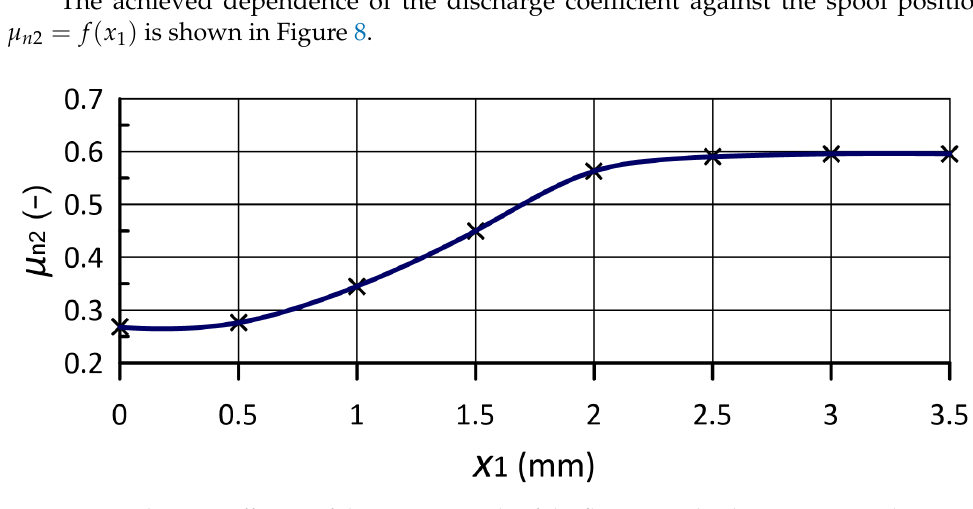
Figure 8. Discharge coefficient of the output nozzle of the flow control valve against spool